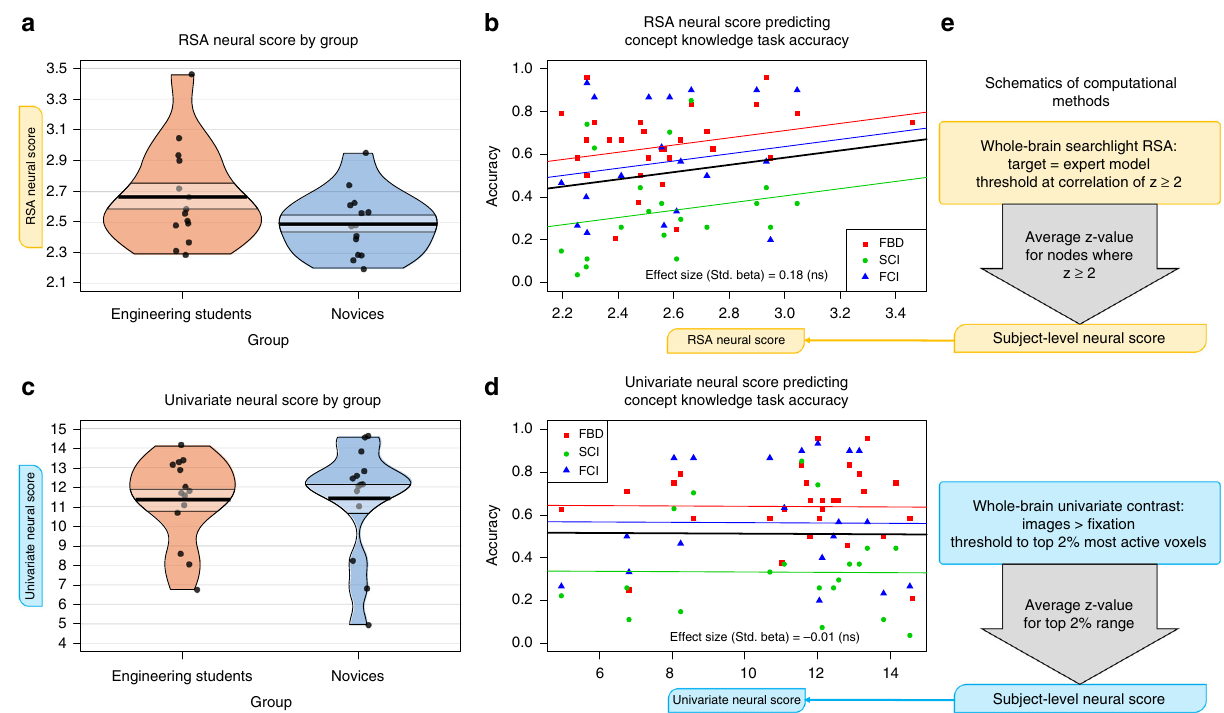
Fig. 3 RSA and univariate neural score results. Neither the RSA neural score a – b nor the univariate neural score c – d from the fi rst fMRI run signi fi cantly differentiated the participants by group, and neither was signi fi cantly predictive of concept knowledge. Regression outputs in b and d follow the same format as Fig. 2b, with effect size (standardized beta parameter) printed at bottom of each plot. Schematics on the right e outline the computational method for the RSA and univariate neural scores, following the format used in Fig. 2c